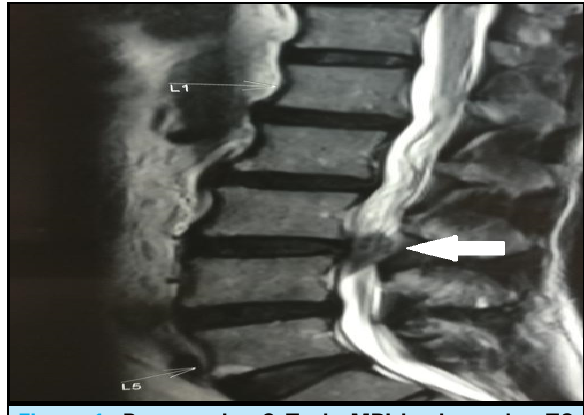
Figure 1. Preoperative 3 Tesla MRI lumbar spine T2 weighted sagittal